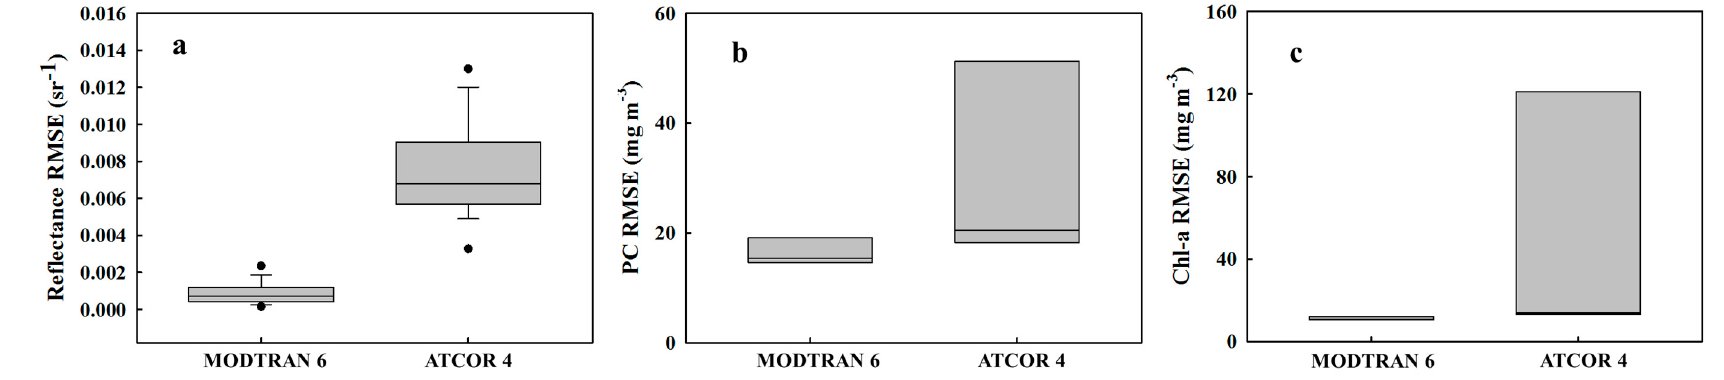
Figure 15. Influence of atmospheric correction using MODTRAN 6 and ATCOR 4 on the PC and Chl-a quantification. ( a – c ) are error of atmospheric correction, PC, and Chl-a, respectively, in terms of MODTRAN 6 and ATCOR 4.